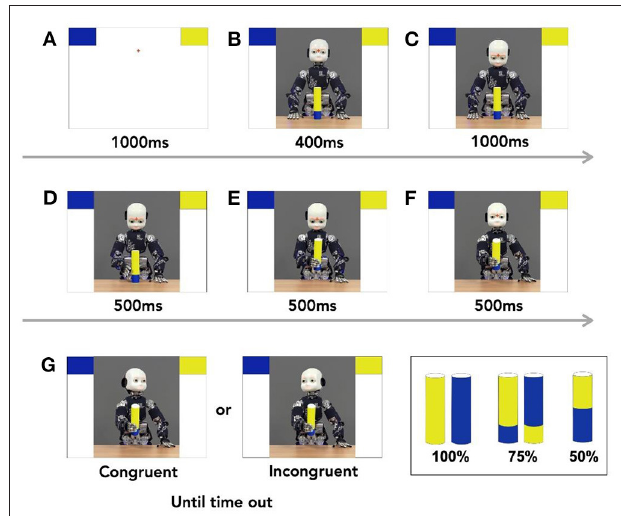
FIGURE 1 | (A–G) Task sequence. Each trial started with two blocks appearing on the two upper corner of the screen. A picture of iCub, the humanoid robot appeared and was followed of a sequence of still images that mimicked the movement of handing over the object. After the robot completed handing over the object, it looked congruently or incongruently at one of the two bins. Participants then responded appropriately to where they thought the objects should go. The trial sequence followed the alphabetical order of the panels.